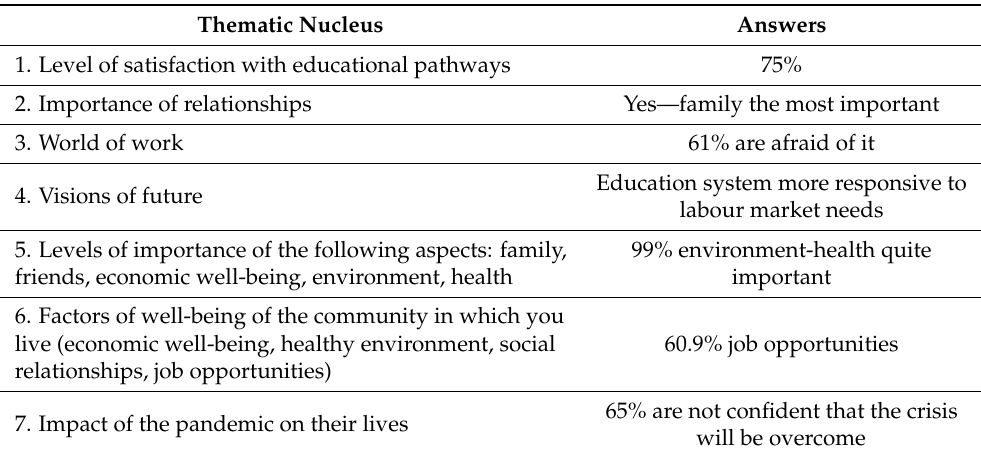
Table 5. The seven macro areas of investigation for young visions of future.